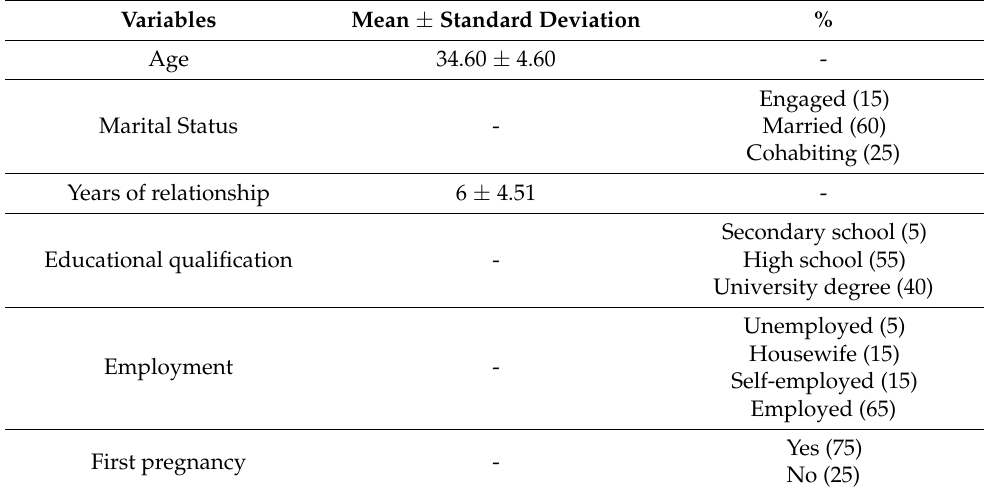
Table 1. Socio-demographic and work context characteristics of the participants.